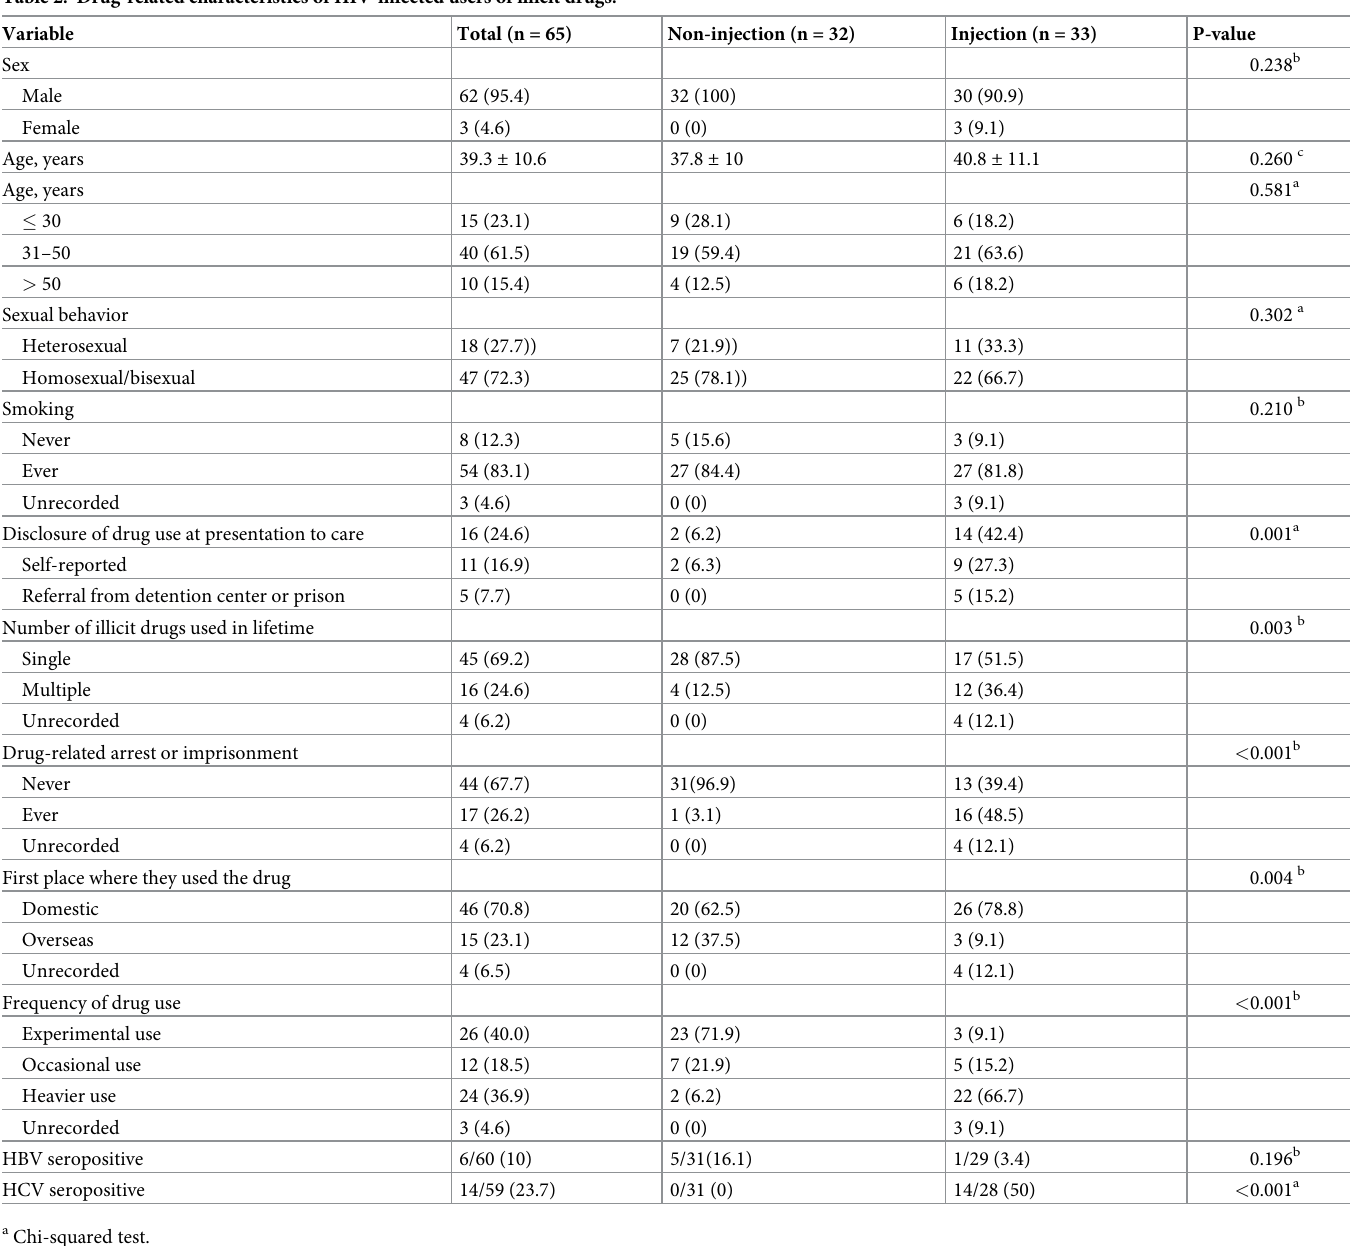
Table 2. Drug-related characteristics of HIV-infected users of illicit